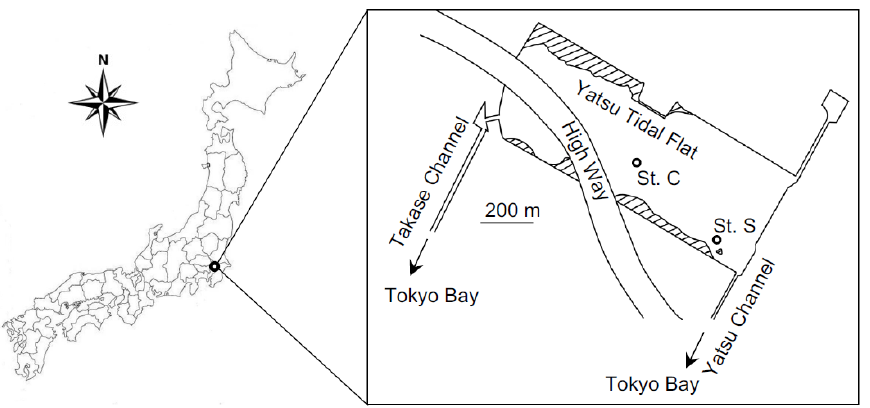
Figure 1. Location of the Yatsu tidal flat, eastern Japan, and sampling Sts. C (35°40.34 ′ N, 140°00.22 ′ E) and S (35°40.29 ′ N, 140°00.27 ′ E) within the tidal flat.